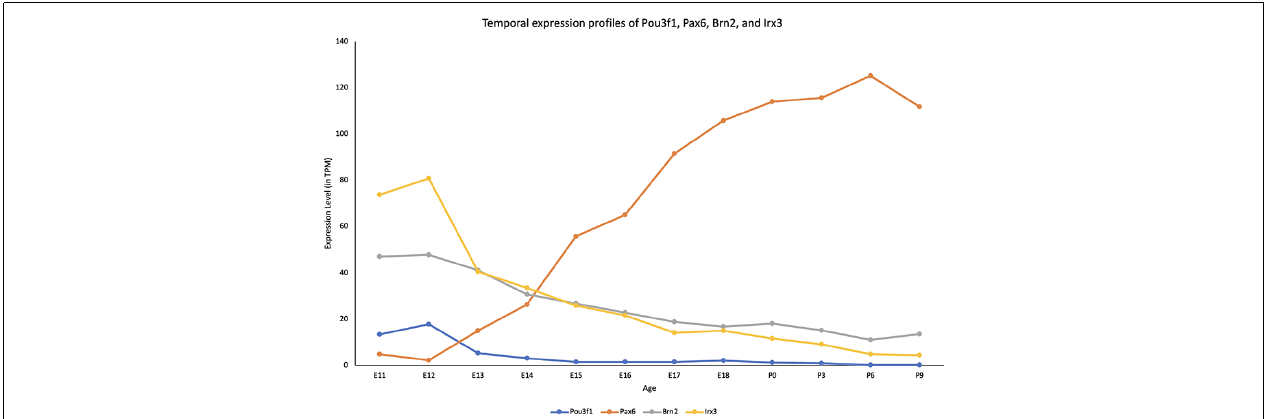
FIGURE 1 | The transcriptional profile of Pou3f1 during cerebellar development based upon the RIKEN FANTOM5 data. The y -axis shows the expression level in transcripts per million (TPM). The x -axis represents developmental timepoints, from embryonic (E) to postnatal (P)